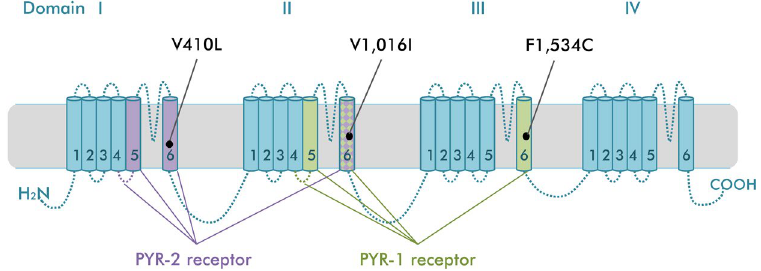
Figure 1. Physical location of V410L, V1,016I and F1,534C replacements in the vgsc . The domain segments and interlink helices forming the pyrethroid receptor sites 1 (green) and 2 (purple) are